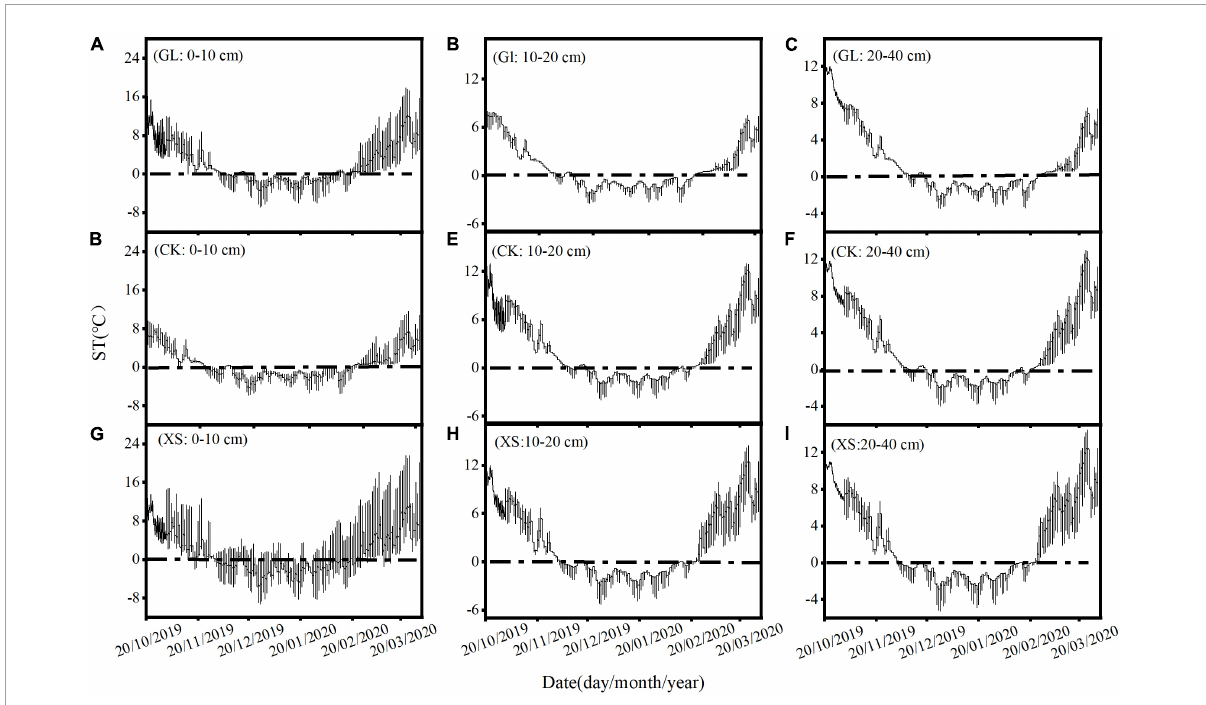
FIGURE2 Soil temperature (ST) records for each soil layer from 0 to 40 cm below ground for GL [ (A–C) ; Grassland], CK [ (D–F) ; Caragana korshinskii ], and XS [ (G–I) ; Xanthoceras sorbifolia ] experimental